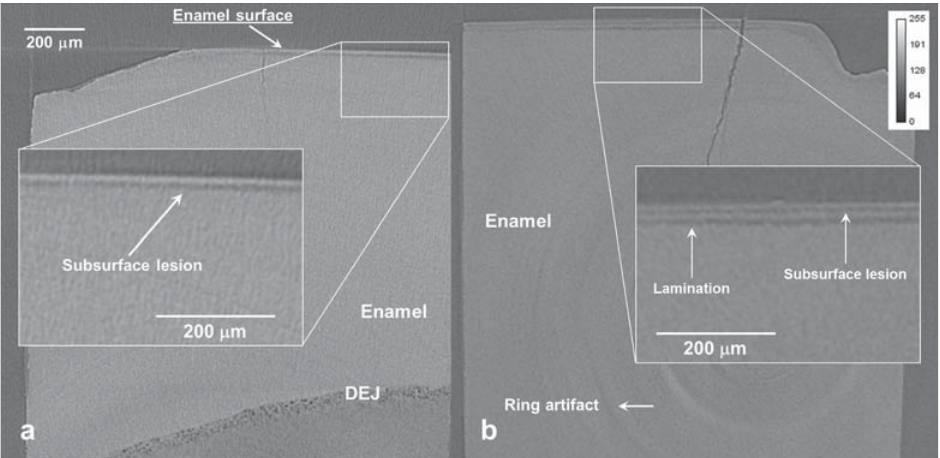
Figure 2- Synchrotron micro-computed tomography (SMCT) slice from a typical specimen of the (a) placebo and (b) ACP 8 h group. The lighter the voxel, the higher the mineral concentration. The dentino-enamel junction is labeled